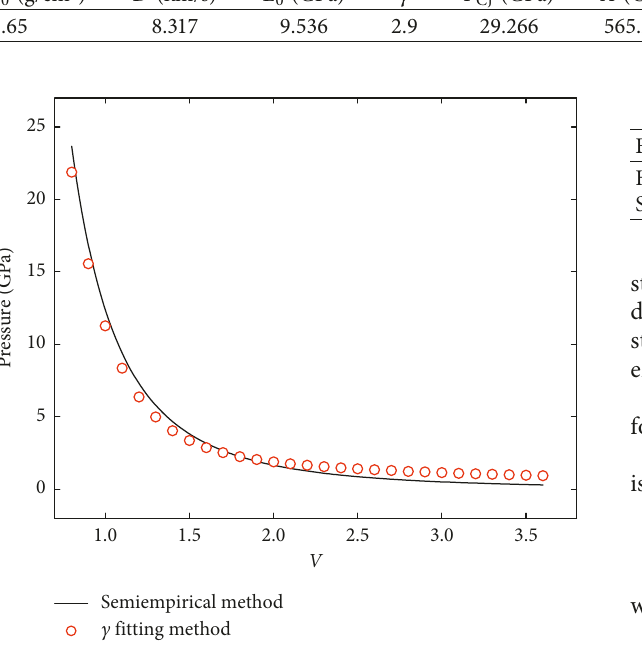
Figure 7: P-V curves of explosive determined by different methods.